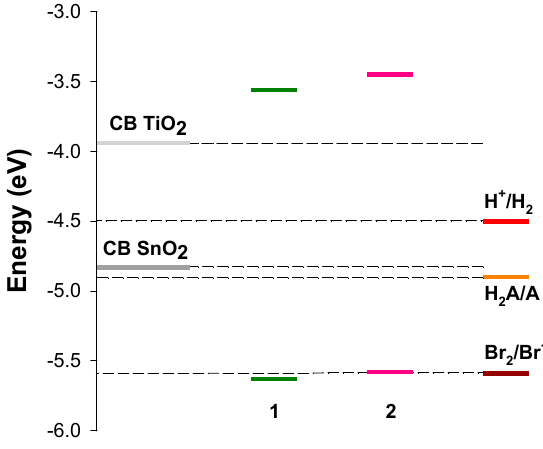
Figure 3. HOMO–LUMO levels for porphyrins 1 and 2.